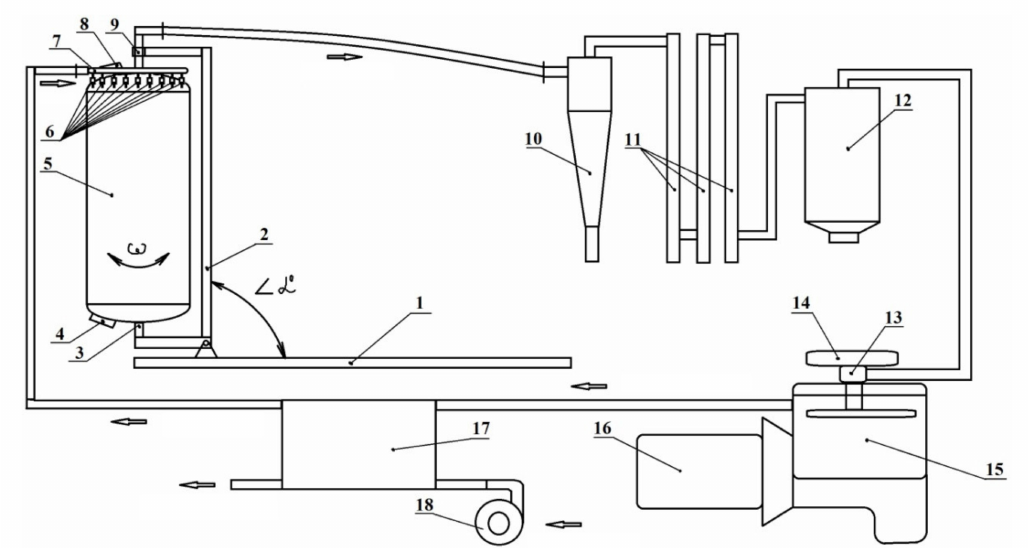
Figure 2. Design of the gas generator system, cooperating with the reciprocating IC engine—own study. 1—foundation, 2—mobile frame, 3—support, 4—ashpan, 5—gas generator core, 6—solenoid valve system, 7—air collector, 8—loading chute, 9—support, 10—gas pre-purification filter, 11—capacitor, 12—gas purification filter, 13—mixer, 14—air filter,